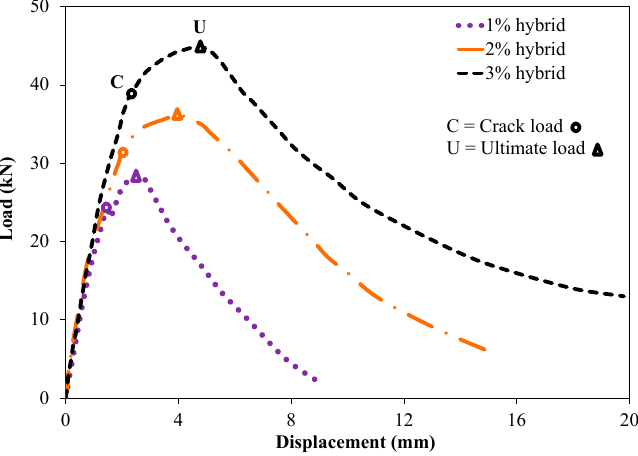
Figure 6. Load–displacement curve of UHPC lining segments under flexural loading.